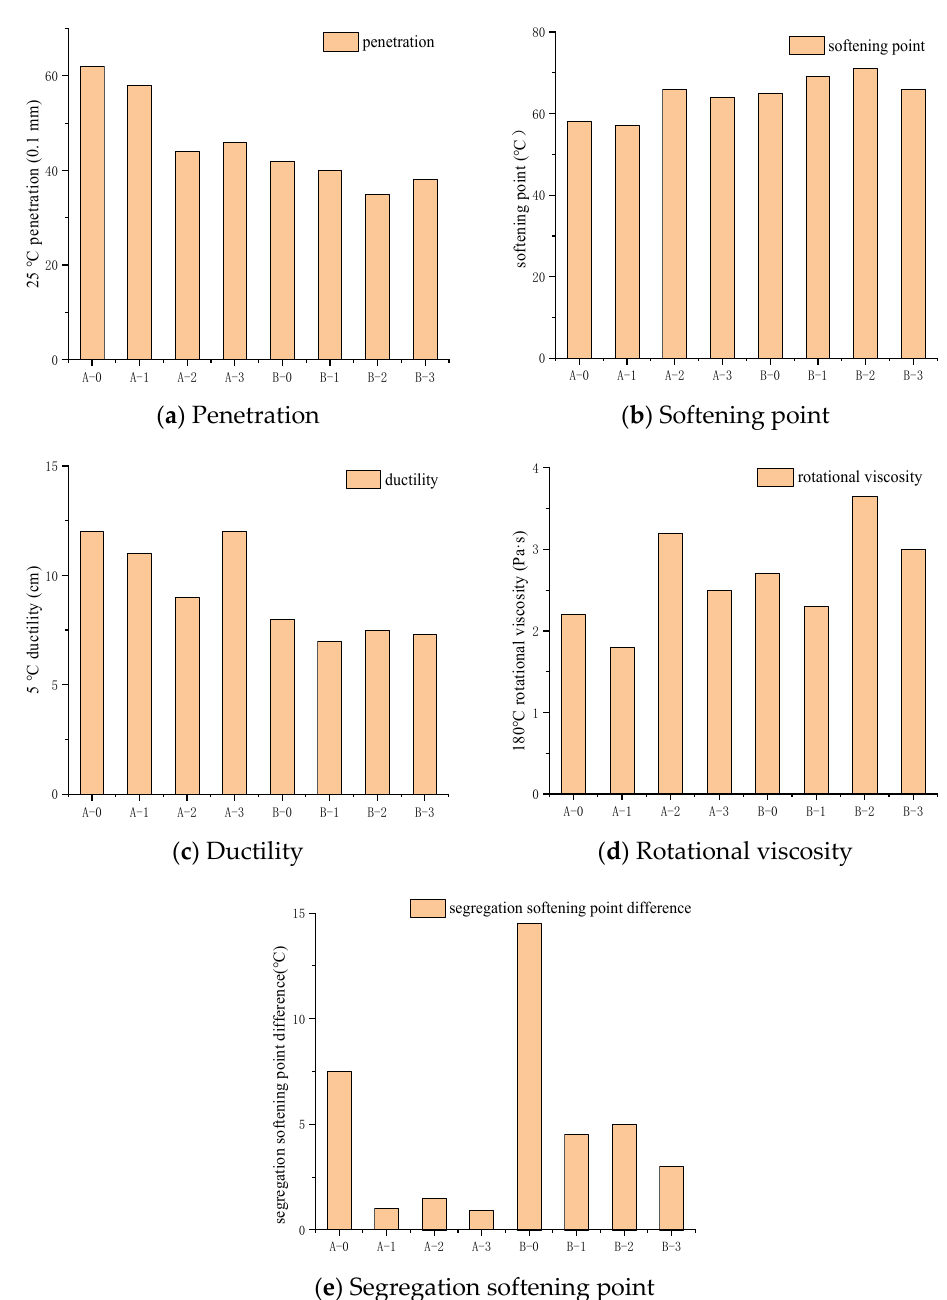
Figure 5. Effect of three stabilizers on the conventional test of AR of A and B. Figure 5. E ff ect of three stabilizers on the conventional test of AR of A and